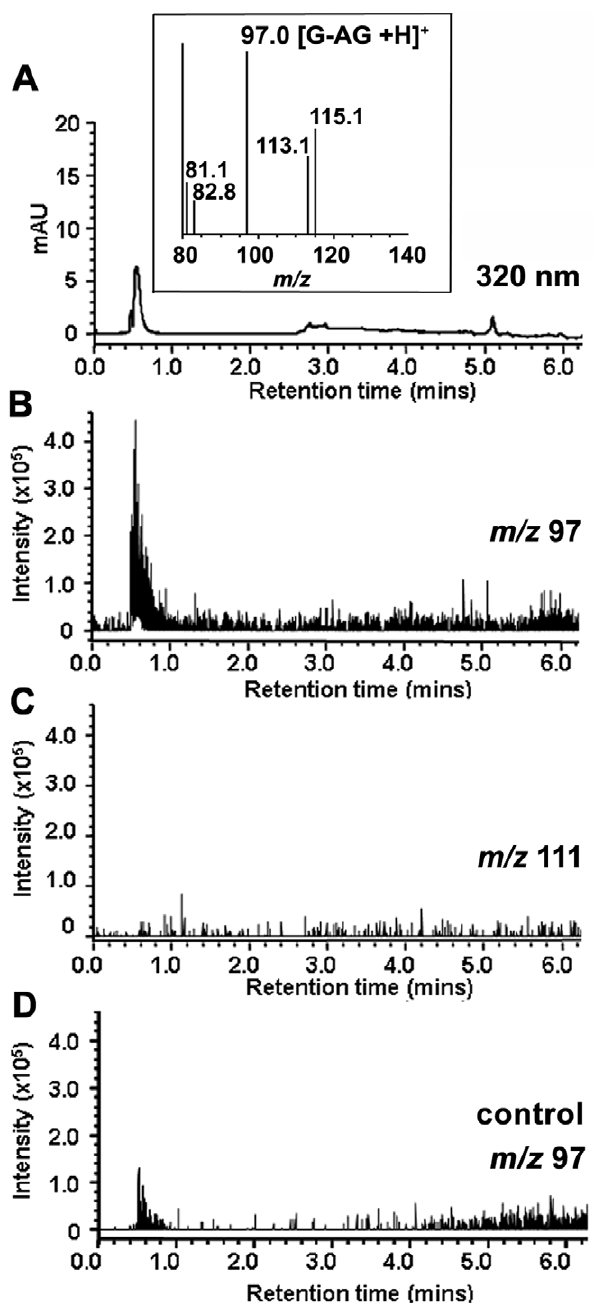
Figure 5. UPLC-MS detection of aminoguanidine (AG)-adducts in extracts of 430 nm irradiated A2E-ARPE19 cells. ( A ) Chromato- gram with UV detection at 320 nm. Irradiated A2E-ARPE19 cells. Inset, mass spectrum of peak eluting at retention time 0.6 mins. ( B,C ) Selected ion monitoring chromatograms at m/z 97 (GO-AG adduct) and m/z 111 (MG-AG adduct). Irradiated A2E-ARPE19 cells. ( D ) Selected ion monitoring chromatogram at m/z 97. Control nonirradiated A2E- ARPE19 cells.